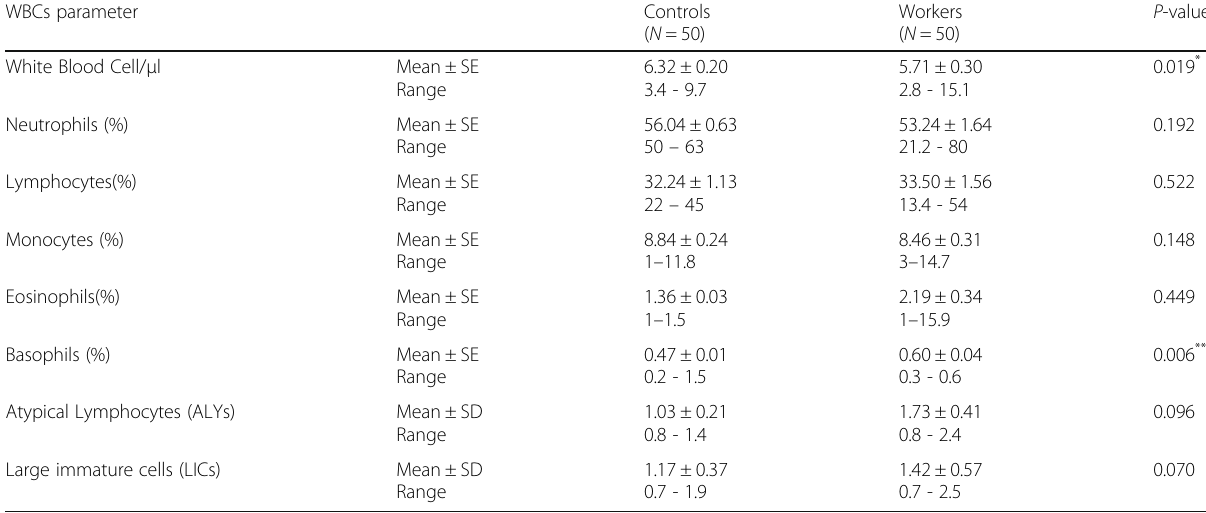
P -value Workers ( N = 50) ( N = 50) Range